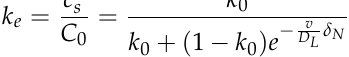
where G L is the temperature gradient, υ is the growth rate, m L is the slope of the liquid line, k 0 is the solute redistribution coefficient, D L is the solute diffusion coefficient, and C 0 is the original alloy composition. It can be seen from Equation (2) that the constitutional undercooling is mainly affected by the temperature gradient D L , the dendritic growth rate v , and the thickness of the diffusion layer δ N . In the actual solidification process, the solute distribution is affected by the cooling rate. This effect is expressed by the effective solute distribution coefficient ( k e ). The effective solute redistribution coefficient can be calculated using Equation (3) based on the theory of Burton